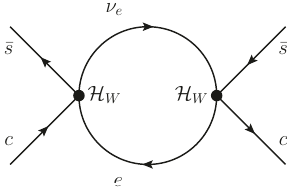
Figure 2 . The four-quark matrix element contributing to the OPE of Im T